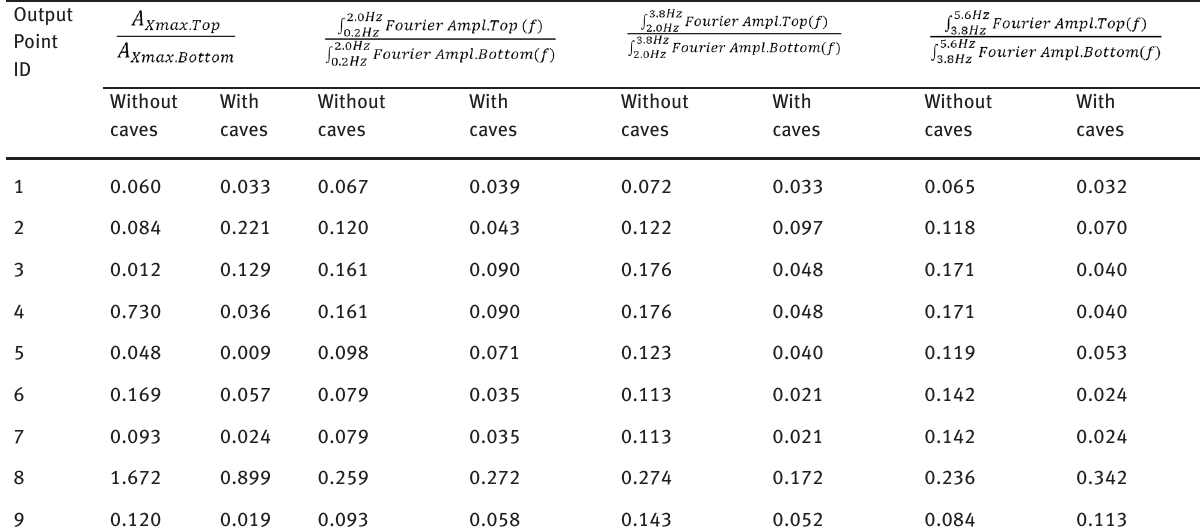
Table 5: FA, calculated in the absence and presence of karst caves, as ratio of the maximum X-acceleration and ratio of the Fourier’s amplitudes spectrum in three ranges of frequency.